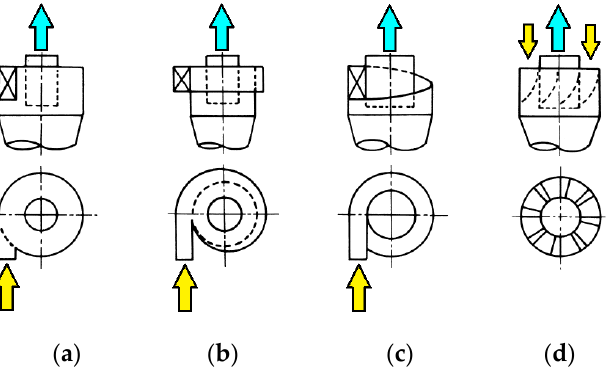
Figure 3. Methods of gas supply to the cylindrical part of a return cyclone with inlet: ( a – c ) tangential, ( d ) axial. Figure made by the author based on data from the work [34].